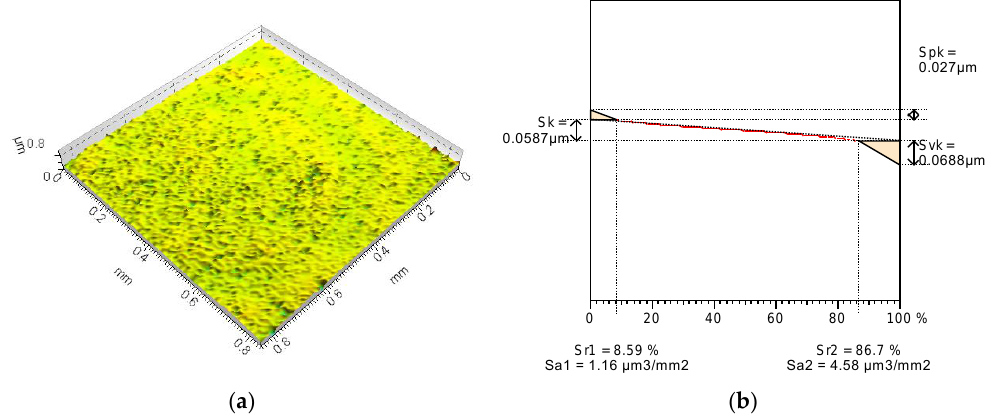
Figure 1. Base surface no. 1 (3D view) ( a ) and Abbott-Firestone curve with Sk-family parameters ( b ) [20].